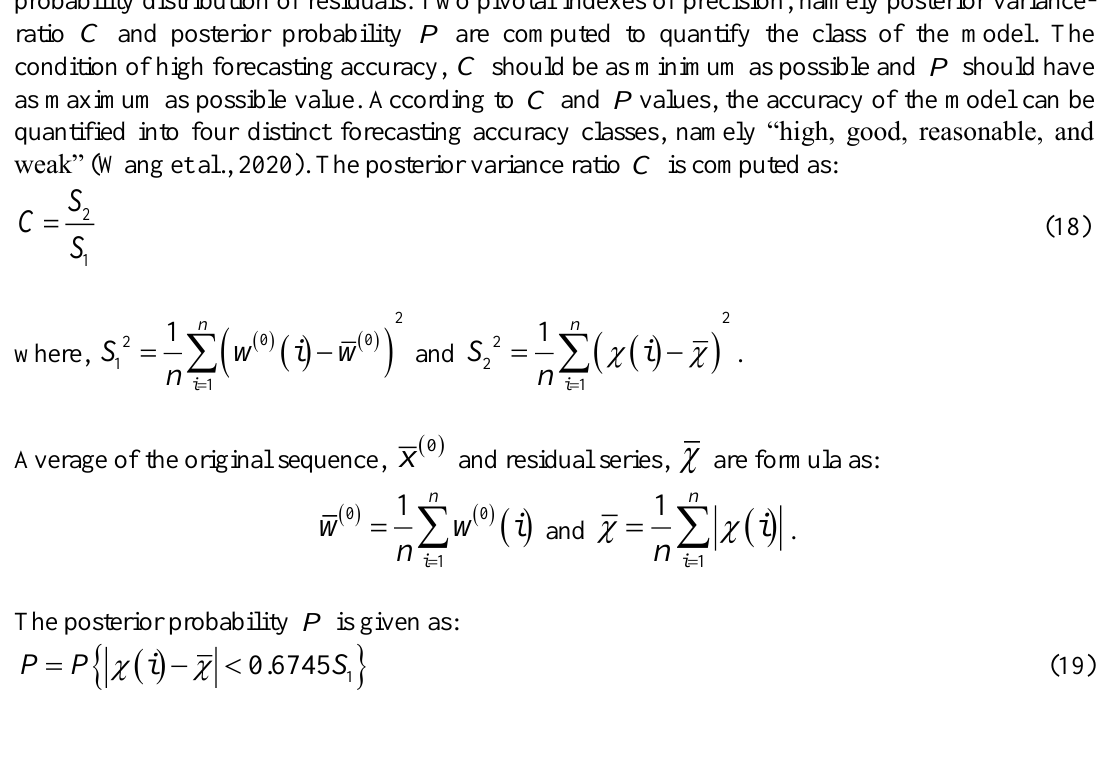
Table 2. The forecasting accuracy quantification